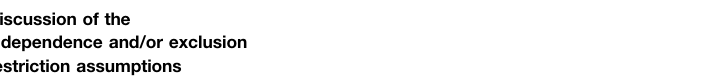
TABLE 4 | Discussion of the independence and/or exclusion restriction